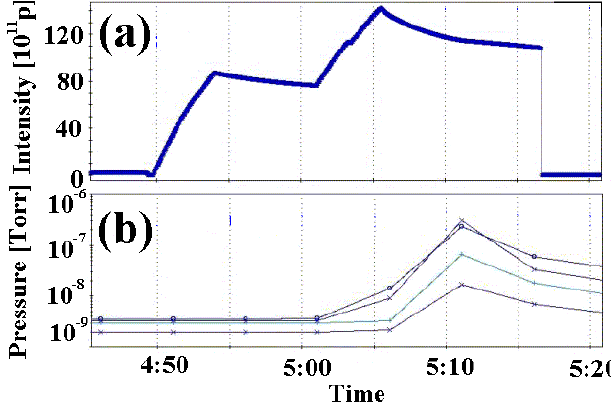
FIG. 24. (Color) Increase of gas density in cold arcs (b), as measured by 4 gauges, when protons are injected (a). The increase of the gas density is measured with a warm gauge connected to the cold vacuum through a small diameter conduit.